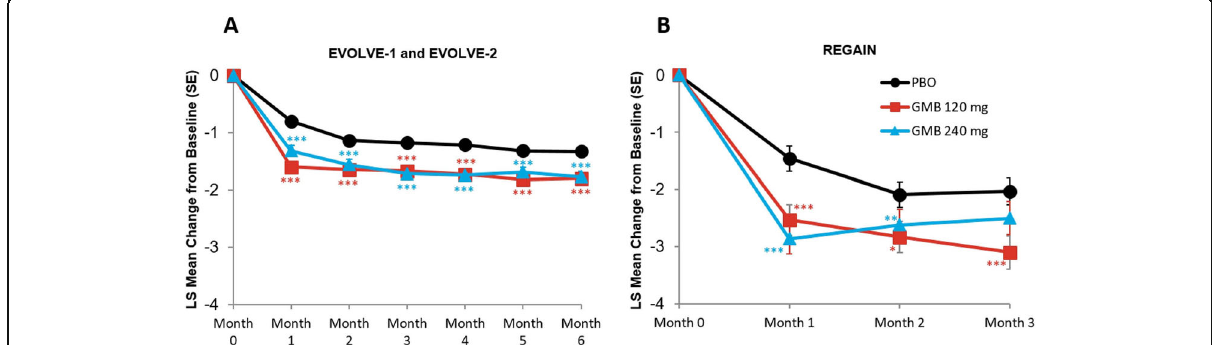
Fig. 6 Monthly mean change in number of severe migraine headache days. * p ≤ 0.05 vs PBO; ** p ≤ 0.01 vs PBO; *** p ≤ 0.001 vs PBO. GMB, galcanezumab; LS, least squares; PBO, placebo;SE, standard